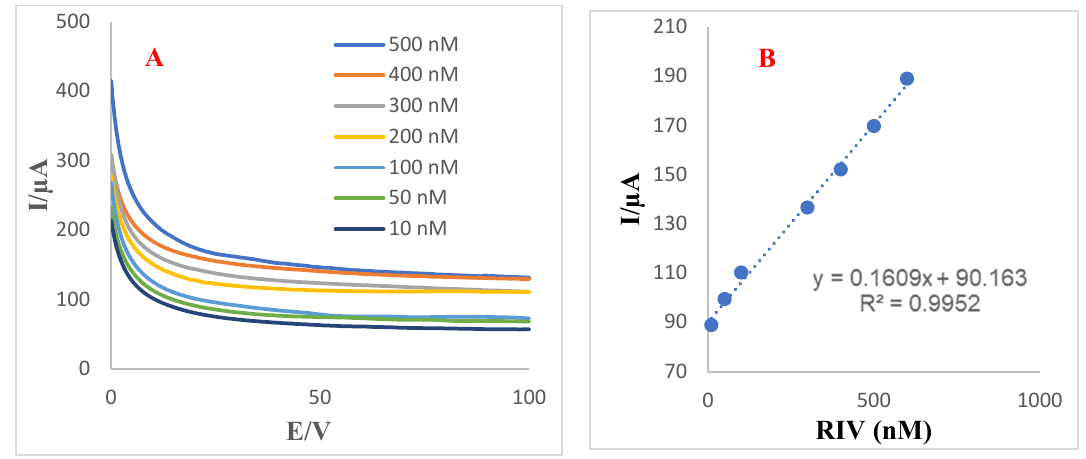
Figure 4. ( A ) ChAs of the engineered aptasensor in different concentrations of Riv in unprocessed human EBC samples. ( B ) Relationship between Ipa and Riv concentration in plasma sample. t eq = 2, E being = − 1 V, E end = 1 V, E step = 0.1 V, amplitude = 0.001 V, and frequency = 10 Hz. Using [Fe(CN) 6 ] 3 − /4 − / KCl (0.01 M)] as the supporting electrolyte (n = 3).